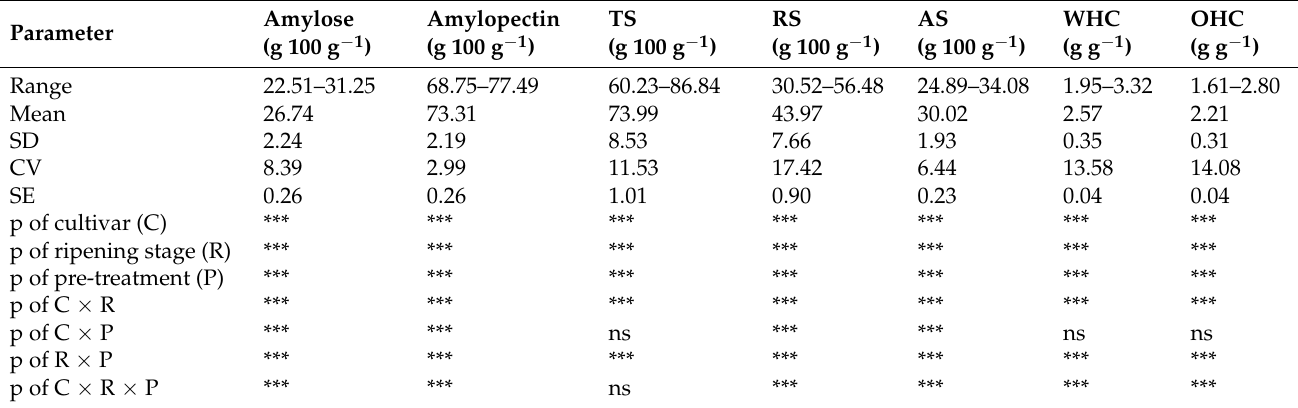
Table 2. ANOVA statistics showing the effect of cultivar, ripening stages, and pre-treatment methods on the starch composition and hydration properties of plantain